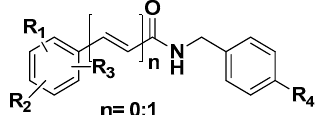
Figure 1. Structural skeleton of synthesized amides with substituents R 1 , R 2 and R 3 = H, Cl, OH, CH 3 , OMe, NO 2 , tert -Bu or C 6 H 5 , and R 4 = F, Cl, or Br.